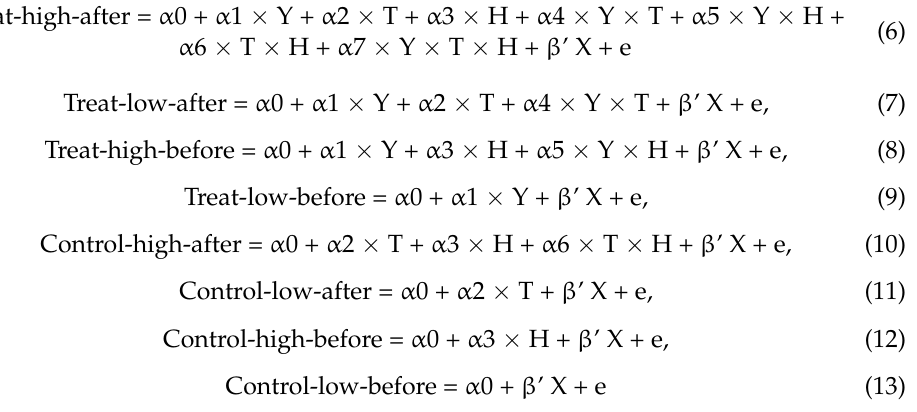
Table 2. Unconditional DDD